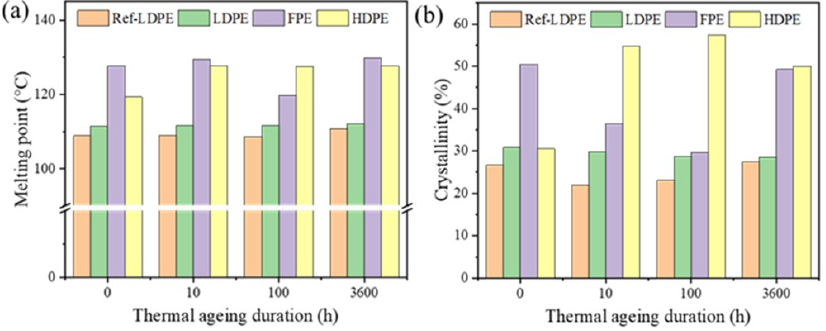
Figure 3. ( a ) Melting point and ( b ) crystallinity of PE samples with different thermal aging